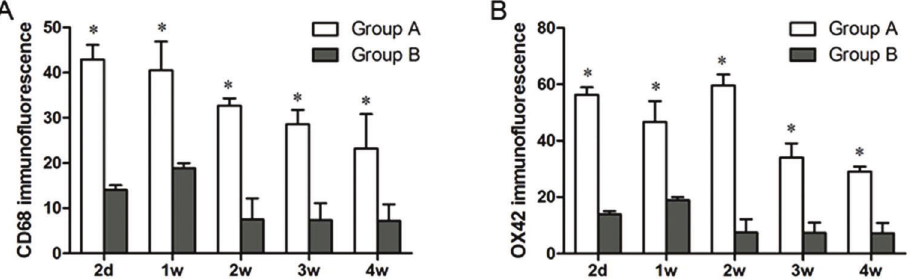
Figure 5. Immuno fl uorescence staining of microglial cells in the microglial cell transplantation group A and saline injection group B. A , CD68 + immuno fl uorescence intensity; B , OX42 + immuno fl uorescence intensity. Data are reported as means ± SD. *P o 0.05 compared to group B ( t -test). d: day(s); w: